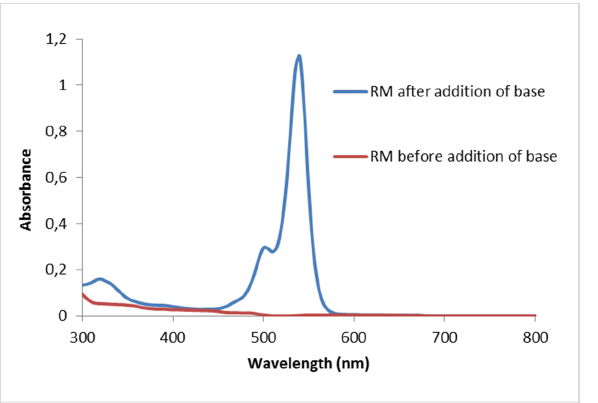
Figure 1: UV–vis spectra of the photoborylation reaction mixture (RM).